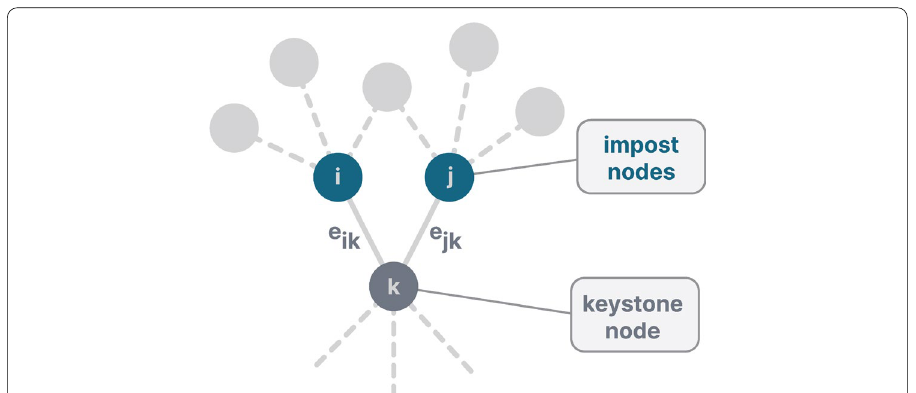
Fig. 2 Illustration from Ahn et al. (2010). As can be seen, only the neighbourhood of the impost nodes is taken into